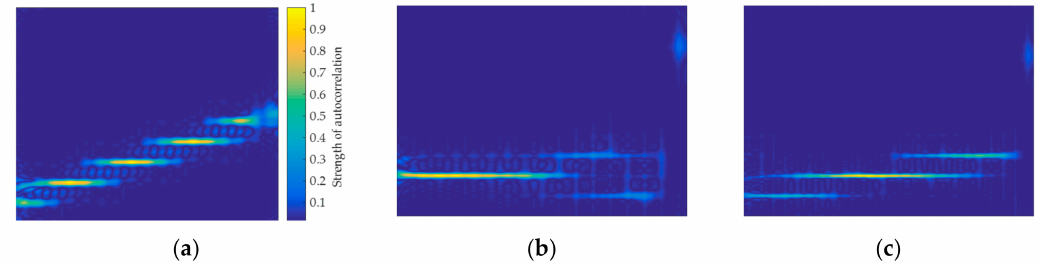
Figure 7. Short-time autocorrelation images of LFM, T1, and P1 signals: ( a ) LFM; ( b ) T1; and, ( c ) P1.